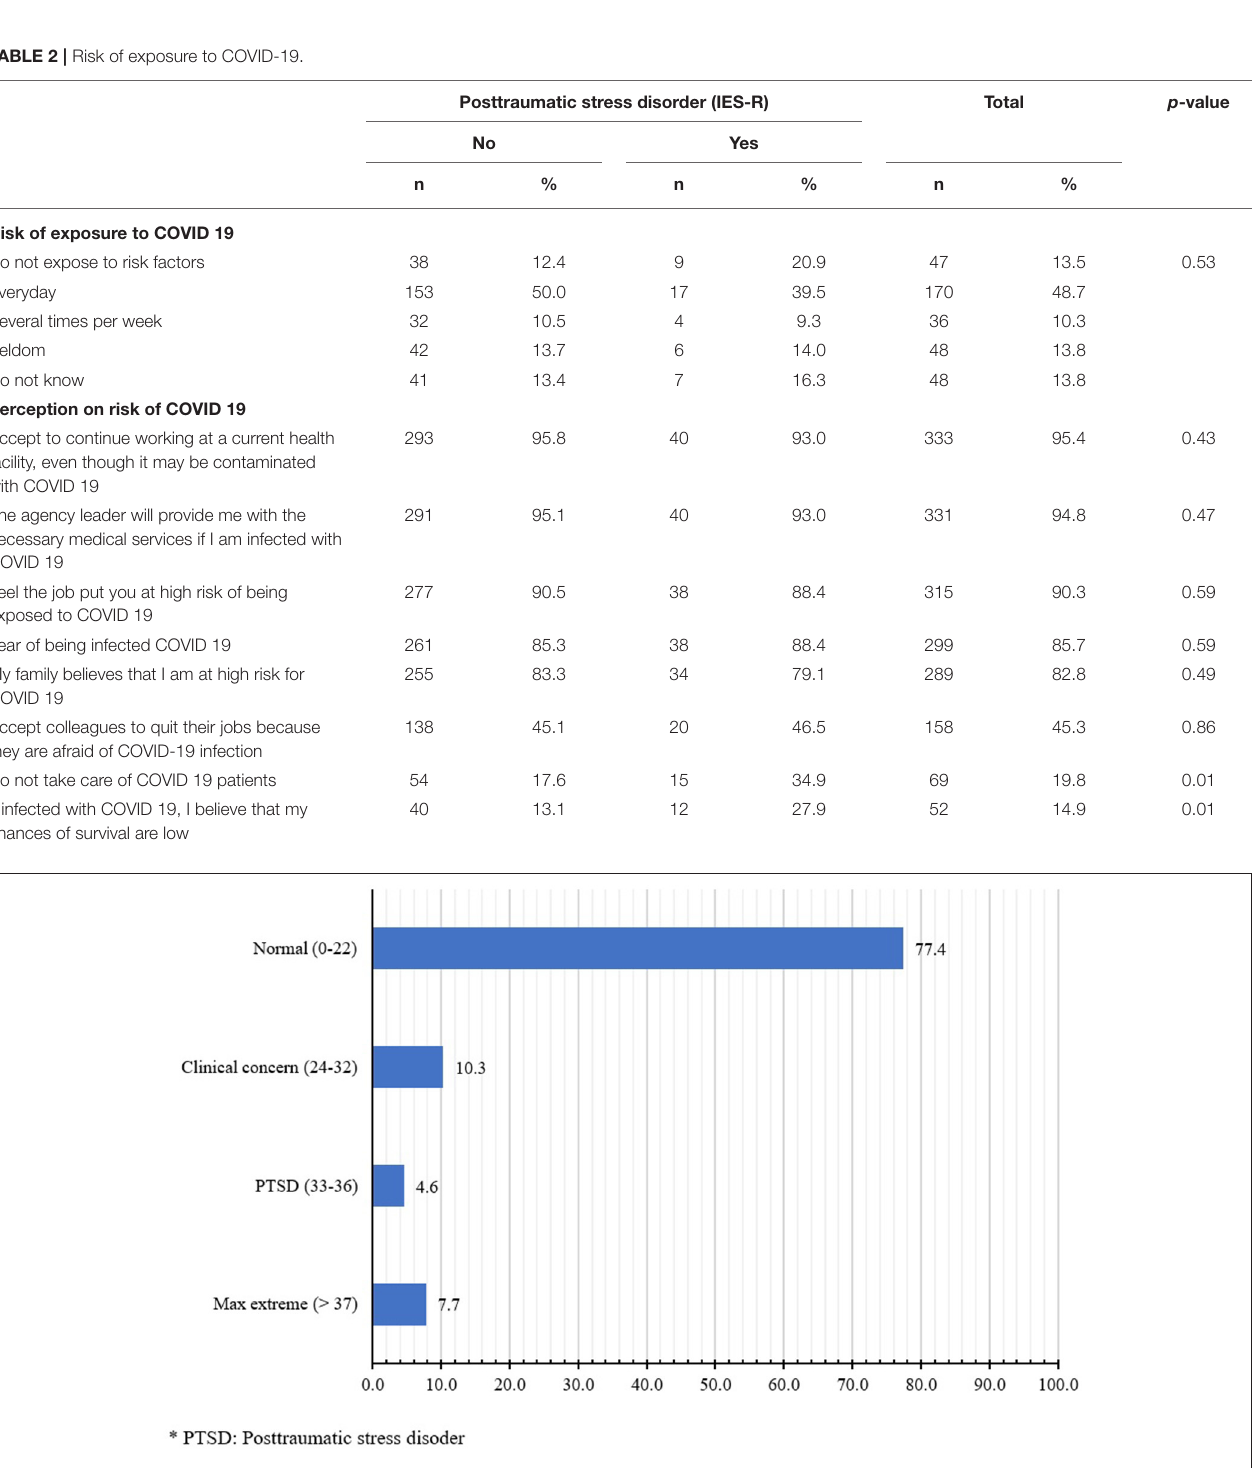
FIGURE 1 | Levels of posttraumatic stress disorder impact by COVID-19 among